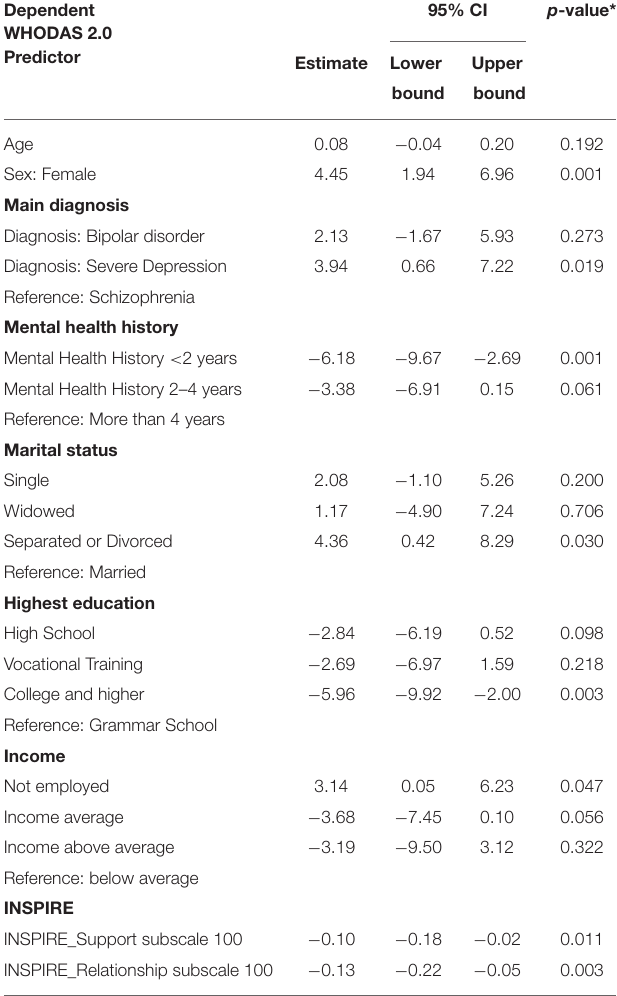
TABLE 3 | Multilevel regression model with WHODAS 2.0 as dependent